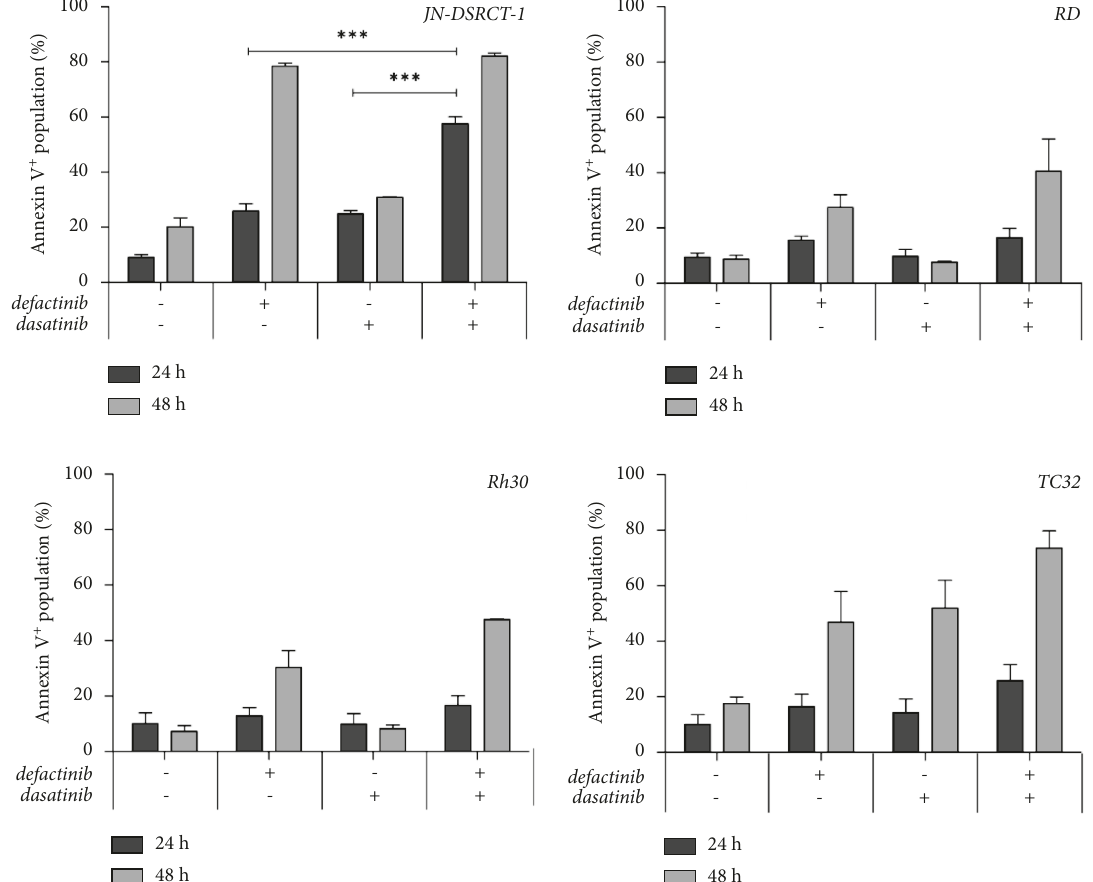
Figure 5: Apoptosis induction following defactinib and dasatinib combination treatment in DSRCT, ERMS, ARMS, and ES cell lines. The level of apoptotic cells (%; annexin V+) following 24h and 48h vehicle, single-agent defactinib, single-agent dasatinib, and defactinib and dasatinib combination treatment in the JN-DSRCT-1, RD, Rh30, and TC32 cell lines. ∗∗∗ p -value <